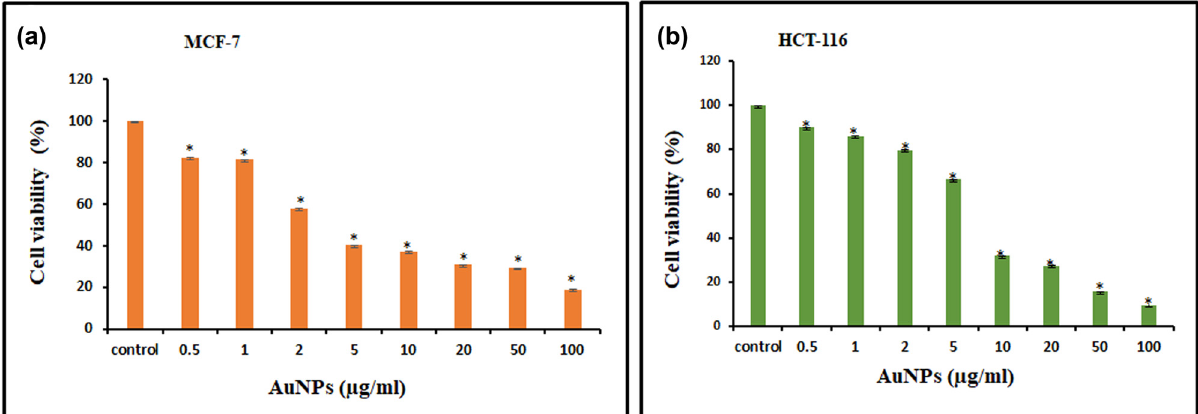
Figure 2: MTT - based cell viability assay. For 24 h, cells were treated with varying concentrations of AuNPs ( 0.5 – 100 µg/mL ) . For both MCF - 7 ( a ) and HCT - 116 ( b ) cell lines, results are reported as column graph with normalized percent cell viability with standard deviation. Data are the mean value ± SD of three independent experiments. Student t - test was performed to determine the signi fi cance. P - values < 0.05 ( compared to control ) were considered a signi fi cant criterion and indicated with * mark over the were found to be cytotoxic in a concentration - dependent and b ) . The percentage of cell viability was found to be manner to MCF - 7 and HCT - 116 cell lines. Di ff erent cell declined even at a very low concentration ( 0.5 µg/mL ) of viability of 40.3 and 66.4% were obtained for MCF - 7 AuNPs, suggesting its high toxicity toward cancer cells. and HCT - 116, respectively, at 5 µg/mL of AuNPs ( Figure 2a